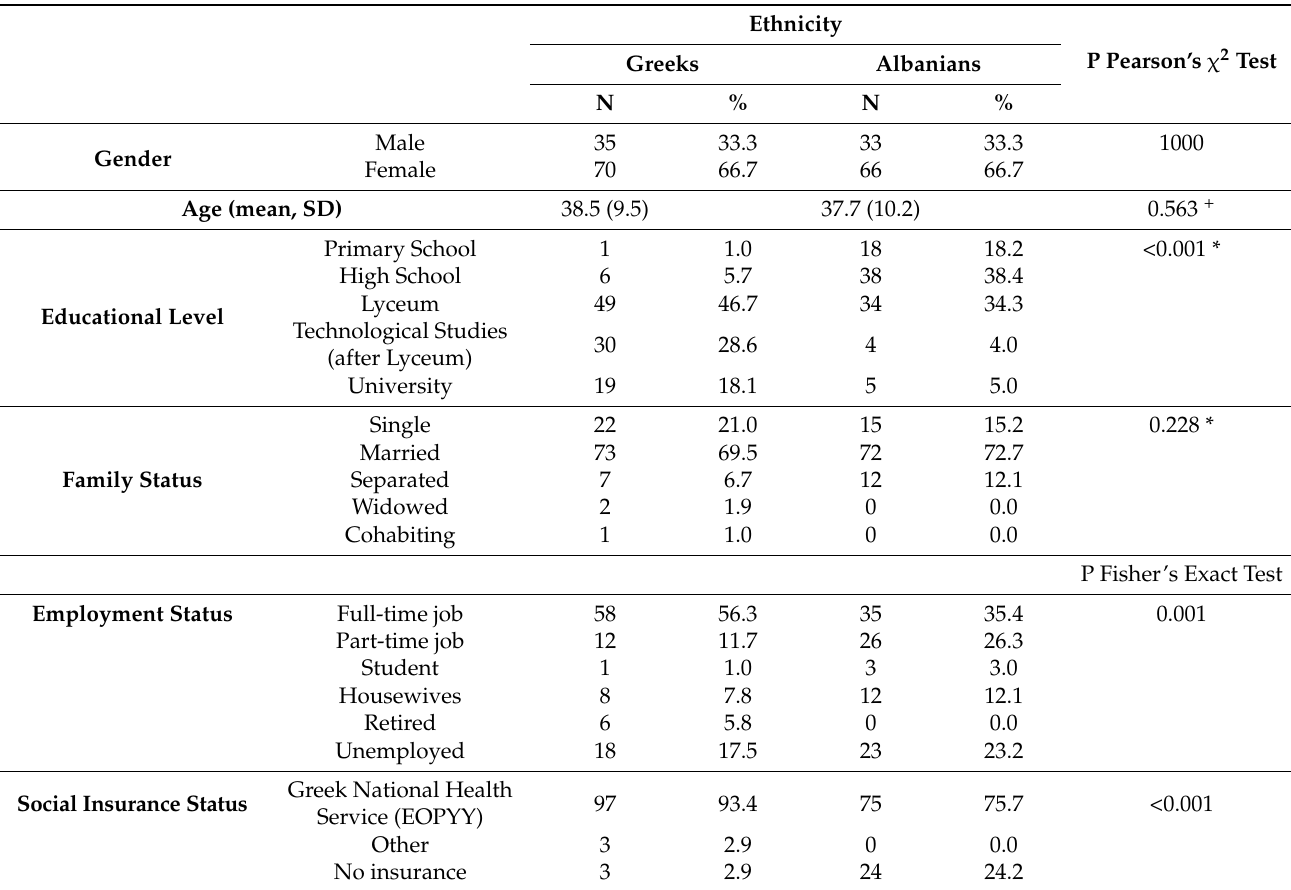
Table 1. Basic sociodemographic characteristics.